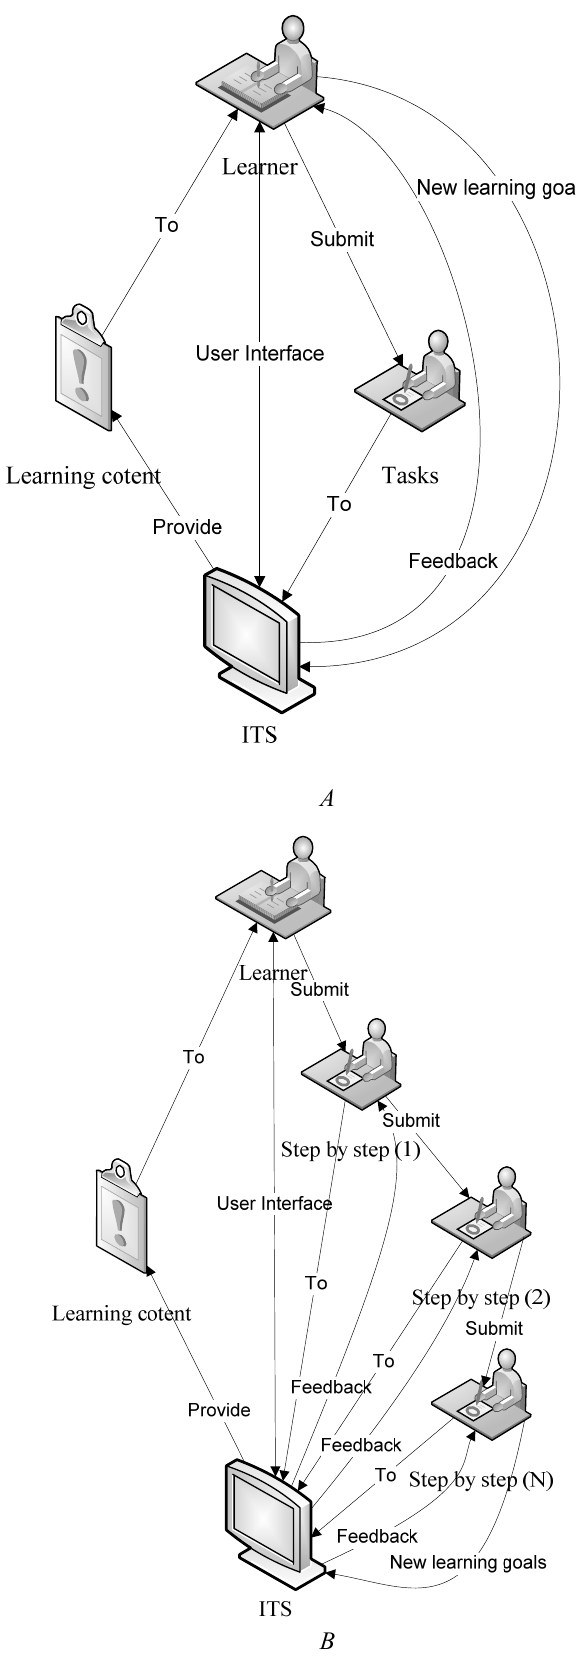
Fig. 3. Feedback comparison A Feedback after task is finished B Immediate